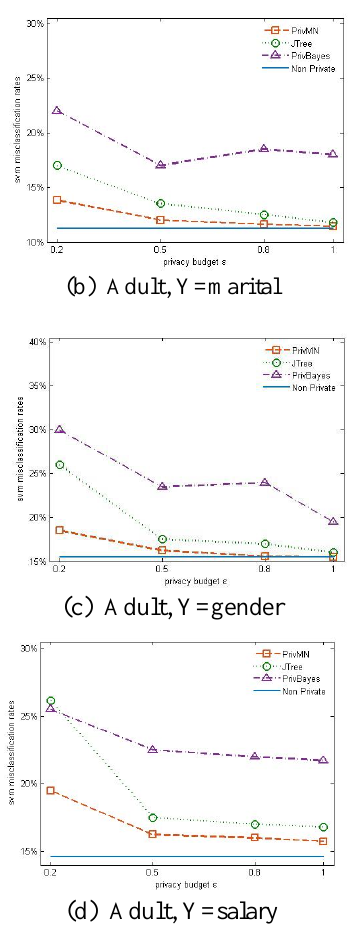
Fig.6. SVM misclassification rates on non-binary